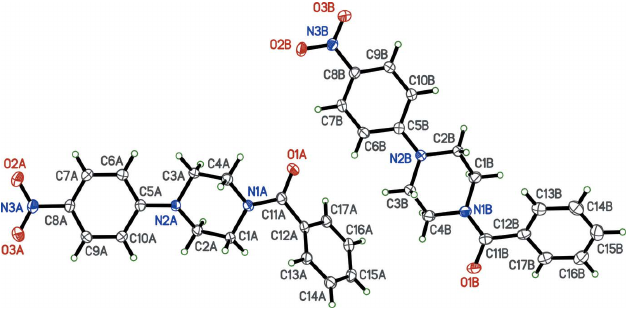
Figure 1 An ellipsoid plot (50% probability) of I showing the two molecules in the asymmetric